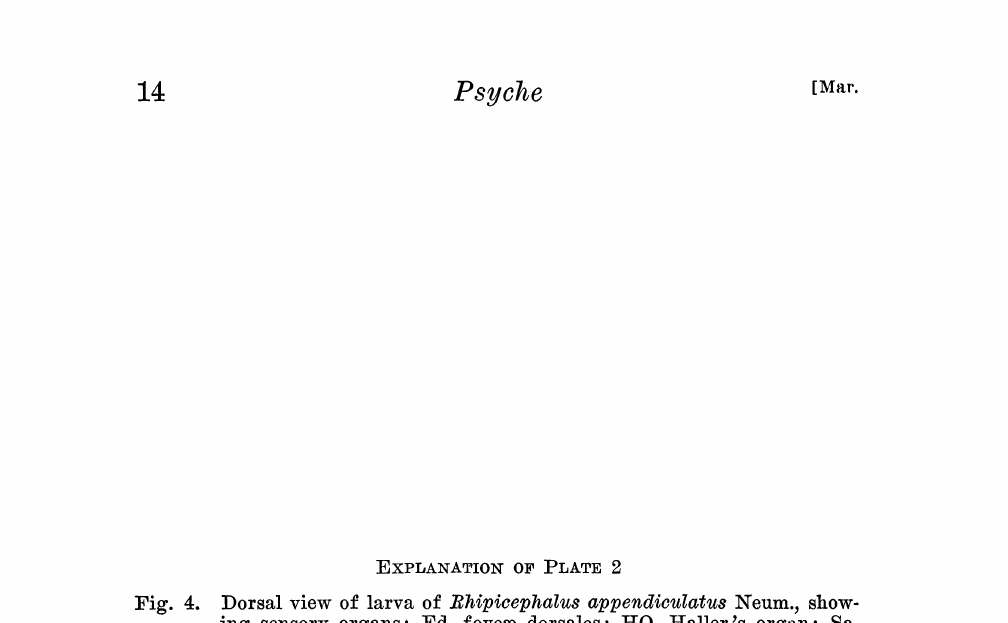
EXPLANAT[ON OF PLATE 2 Dorsal view of larva of lhipicephalus appendiculatus Neum., show- Fig. 4. ing sensory organs: Fd, fovem dorsales; HO, ttaller’s organ; Sa, sensilla auriformia; Sh, sensilla hastifomia; Ss, sensilla sagitti- formia. Ventral view of larva of lhipieephaus appendicuaus Neum., show- ig. 5. ing sensory organs: Sa, sensilla auriformia: Sh, sensilla hasti- formia; Ss, sensilla